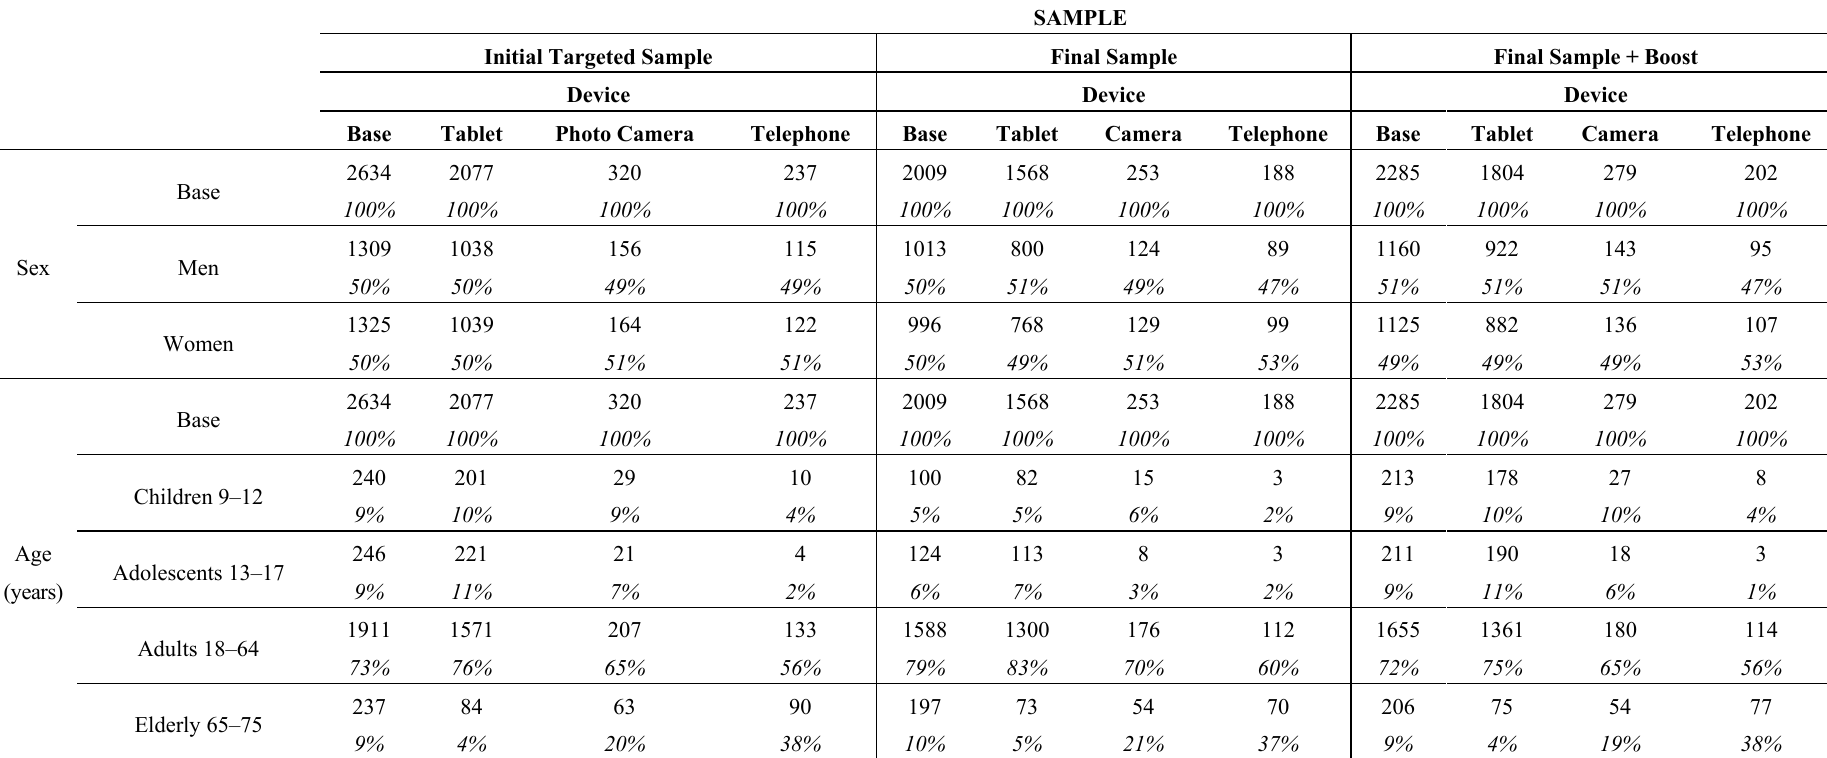
Table 2. Devices used according to sex and age groups for the ANIBES